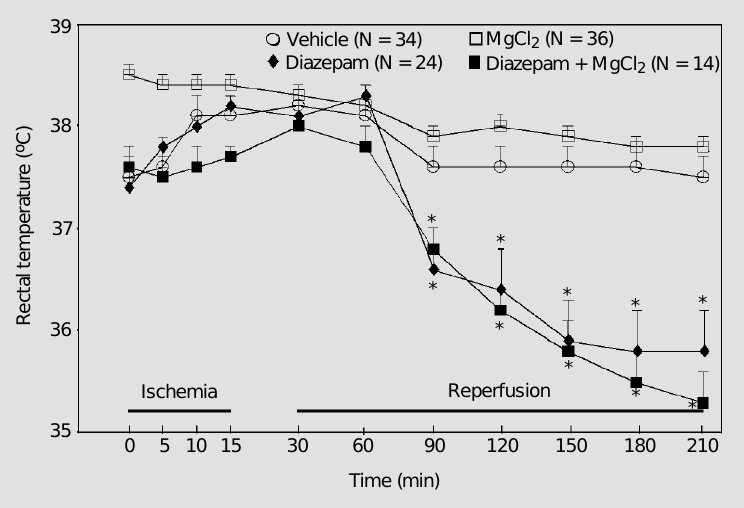
Figure 2 - Effect of MgCl 2 and diazepam alone or in combination on rectal temperature. The groups assigned to the MgCl 2 (2.5, 5.0 or 7.5 mmol/kg) treatments, either as a single dose or as multiple doses, were pooled since core temperatures did not differ among the individual groups. The groups treated with both substances were also pooled, i.e., MgCl 2 (1x) + DZ and MgCl 2 (4x) + DZ. *P<0.05 vs vehicle group. Data are reported as the mean ±